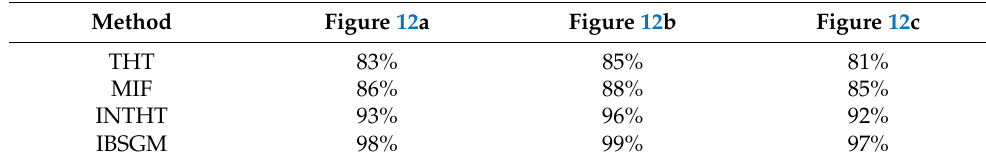
Table 3. Comparison of target retention rates using different